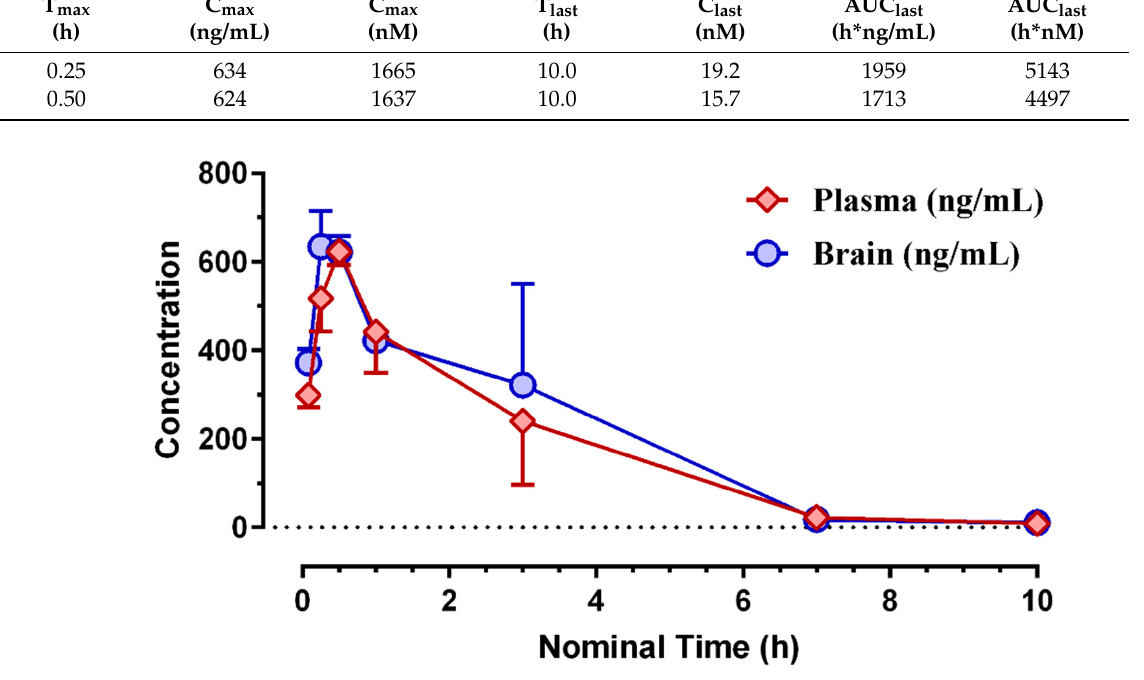
Figure 3. Brain ( blue ) and plasma ( red ) concentrations of ( S )-MK-26 upon i.p. administration with dose of 10 mg/kg of body weight. Table 1. Pharmacokinetic parameters of ( S )-MK-26 upon i.p. administration with dose of 10 mg/kg of body weight.